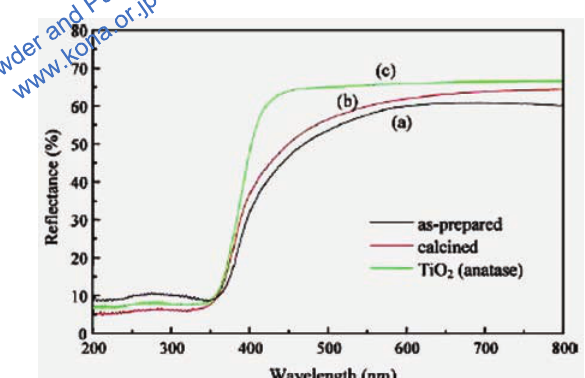
Fig. 16 UV-vis diffuse reflectance spectra of (a) as pre- pared, and (b) calcined hollow mesoporous TiO microspheres, and (c) a well-crystalline 2 TiO 2 sample of anatase phase 76)